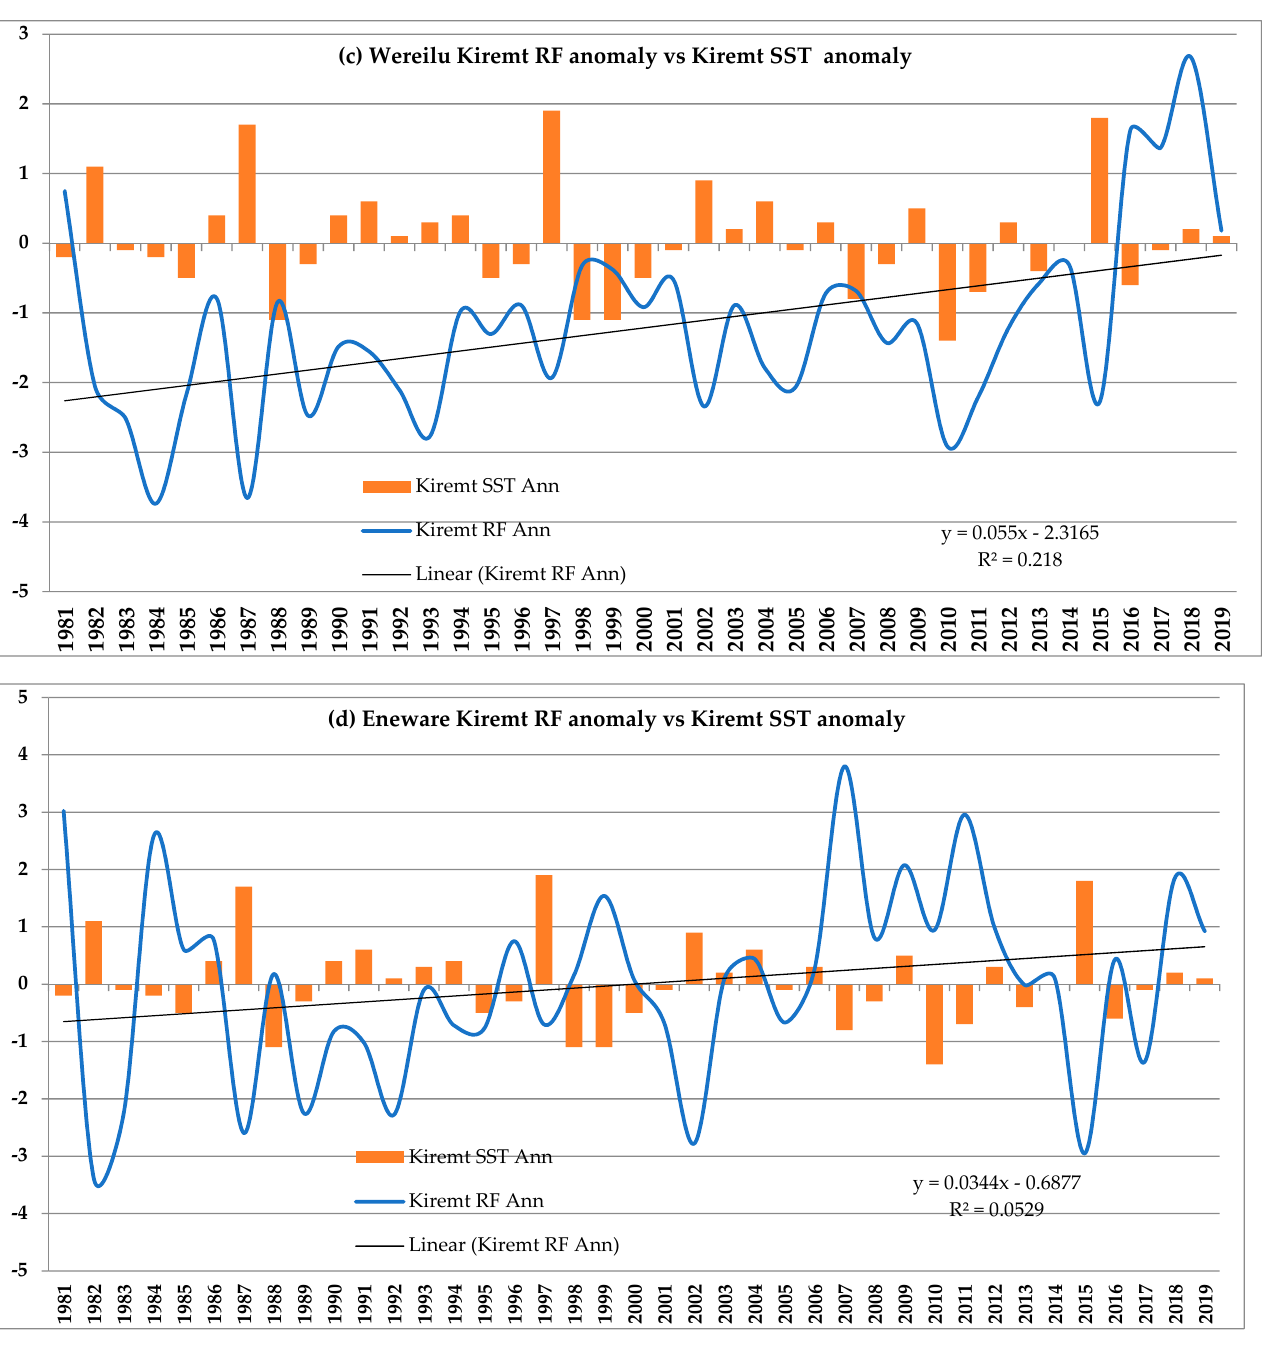
Figure 7. ( a ) AnditTid, ( b ) Gohatsion, ( c ) Wereilu, and ( d ) Eneware Kiremt rainfall anomalies with Kiremt SST anomaly using nino 3.4 downloaded from https://www.cpc.ncep.noaa.gov/data/indices/ersst5.nino.mth.91-20.ascii (accessed on 29 April 2021).